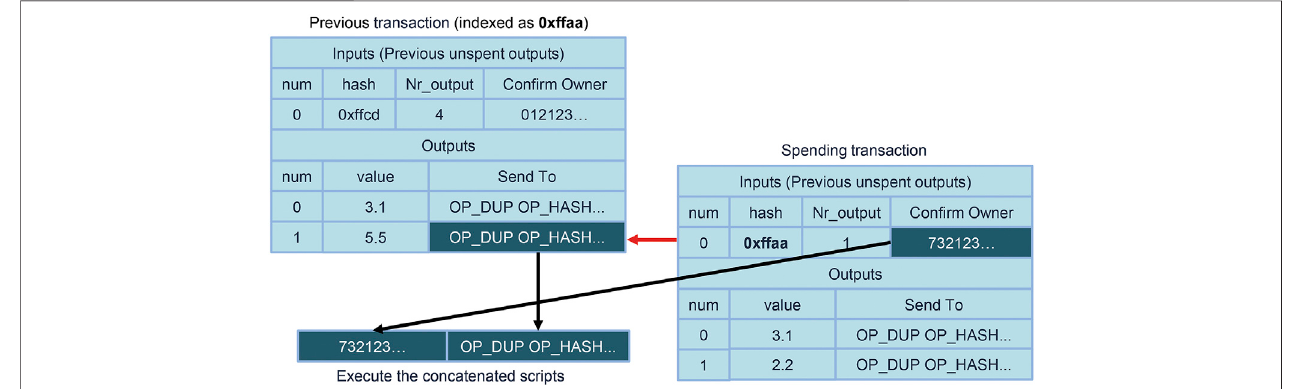
FIGURE 2 | Interaction between the locking and unlocking scripts.